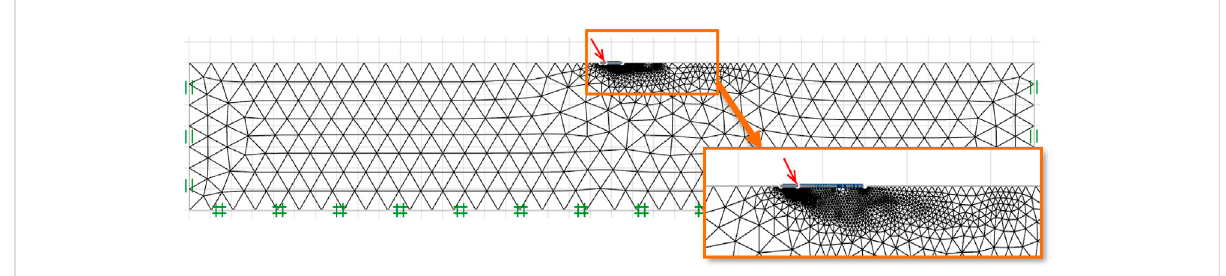
FIGURE 3 Final adaptive meshes of bearing on the rock with β = 60 ° and e/B = 0.3.